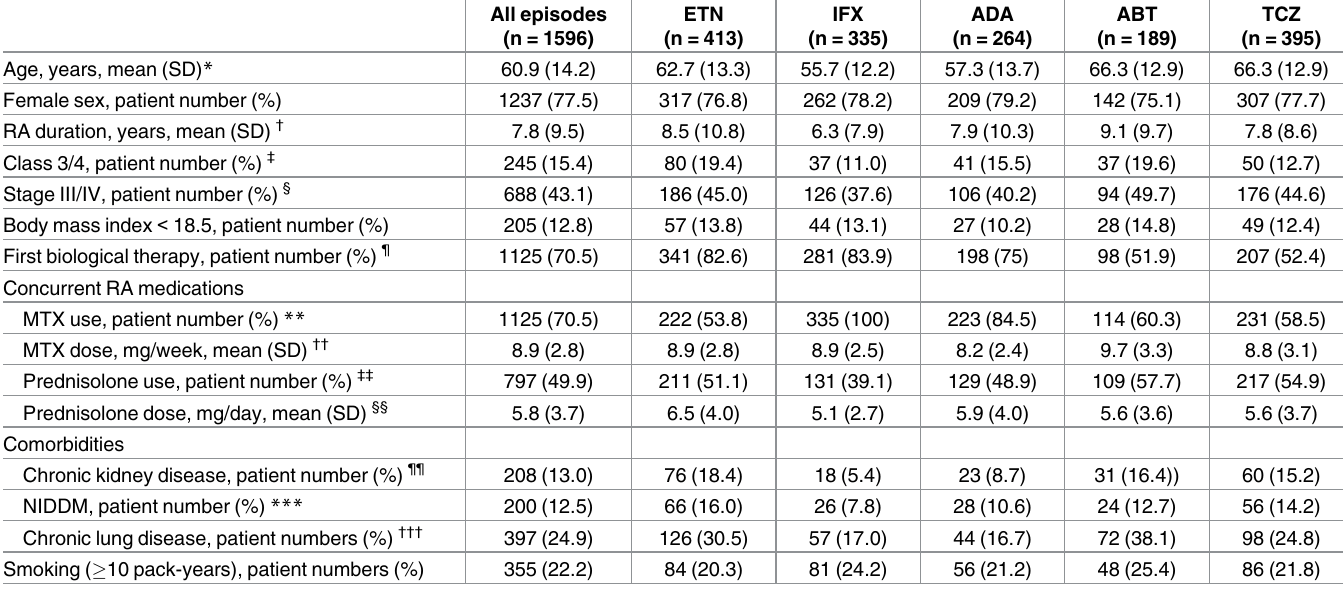
Table 1. Demographic and clinical characteristics of RA patients at the start of a new course of biological